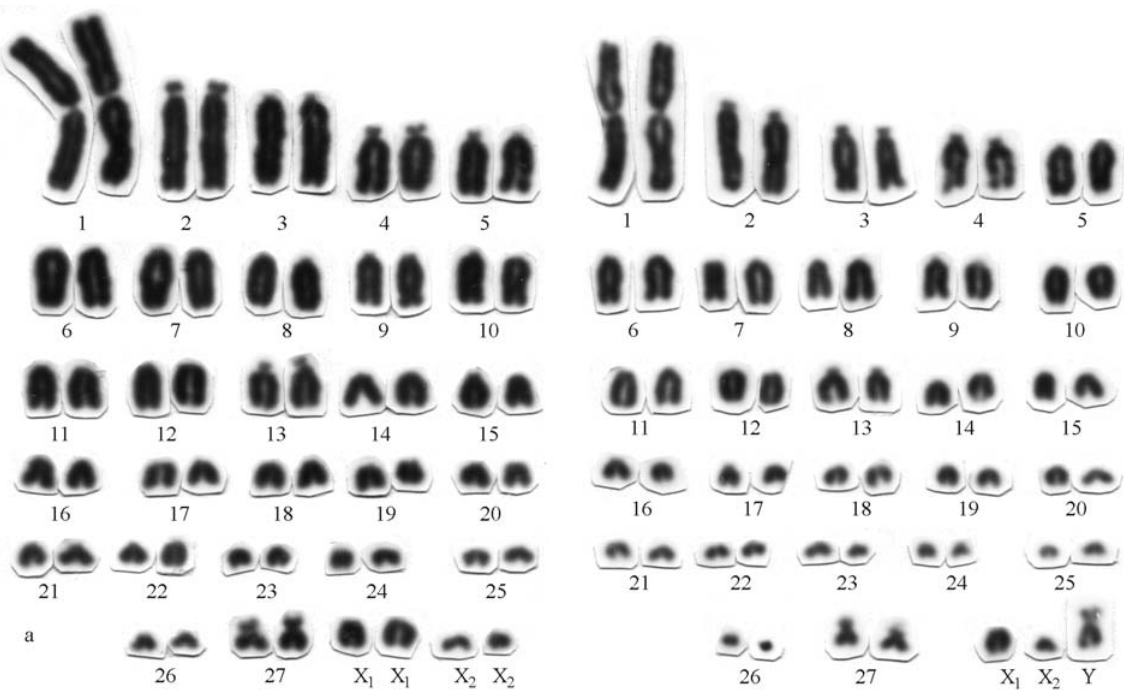
Figure 2 - Giemsa stained karyotypes of (a) Calyptommatus nicterus (2n = 58) and (b) C. leiolepis (2n = 57).